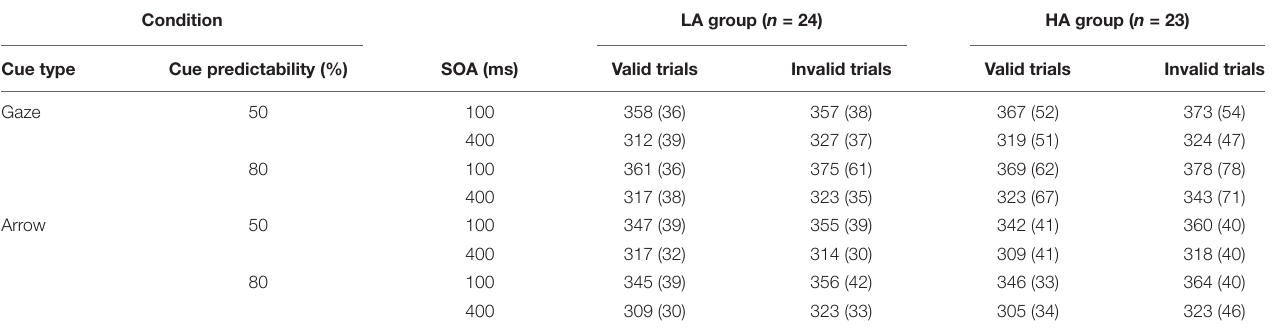
FIGURE 1 | Schematic of an experimental trial. (A) A valid trial for social cue blocks, (B) an invalid trial for non-social cue blocks. Schematic faces in panel (A) are only used for depiction purposes. The actual stimuli used in the experiment was a real face picture from Chinese facial affective picture system (see section Procedure) with permission from the copyright holders of the database. TABLE 1 | Mean reaction times ( SD ) in all conditions for the LA and HA